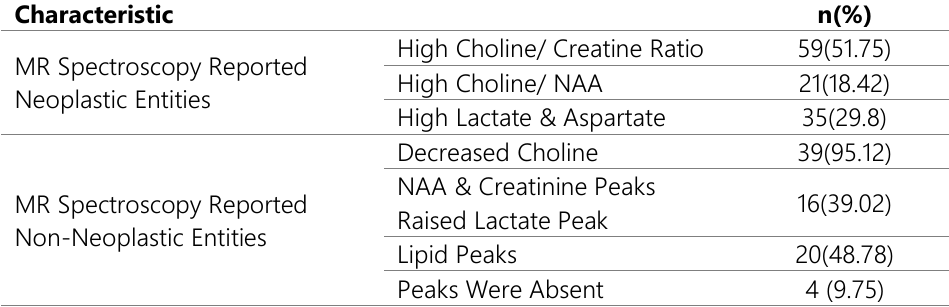
Table 2: Level of chemicals at their